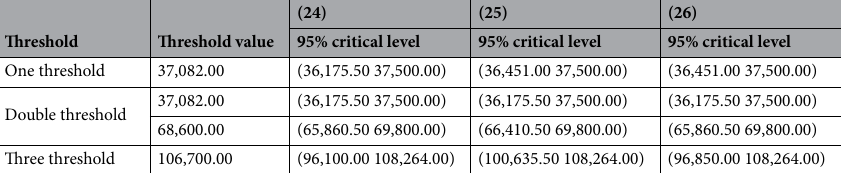
Table 9. Threshold estimation results.